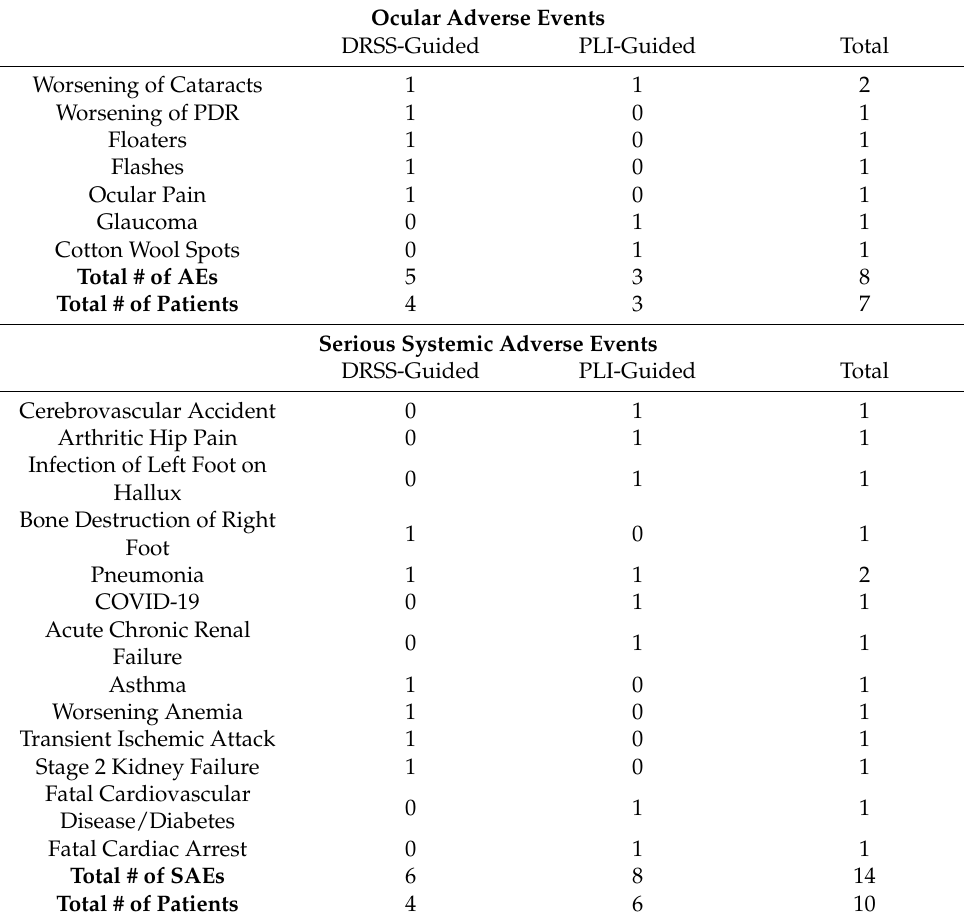
Table 1. Ocular and Systemic Adverse Events in Year